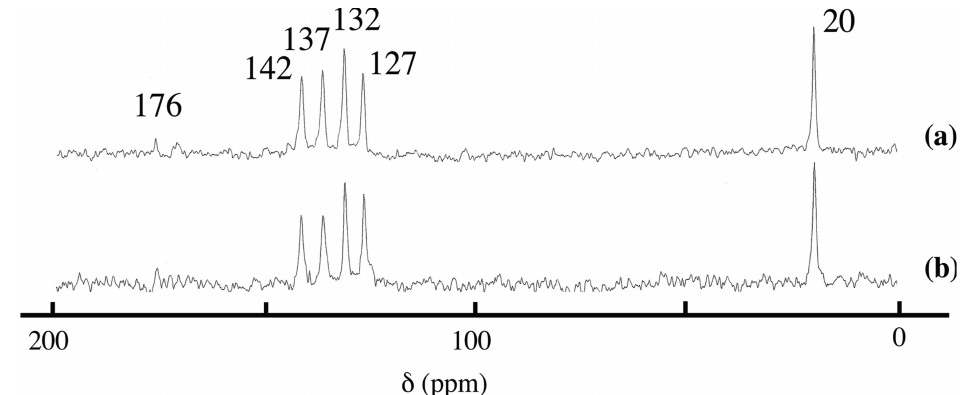
Figure 3. 13 C CP/MAS NMR spectra of sorbate-intercalated LDH obtained ( a ) in a solid-state reaction (sample of Figure 1c) and ( b ) in aqueous solution.